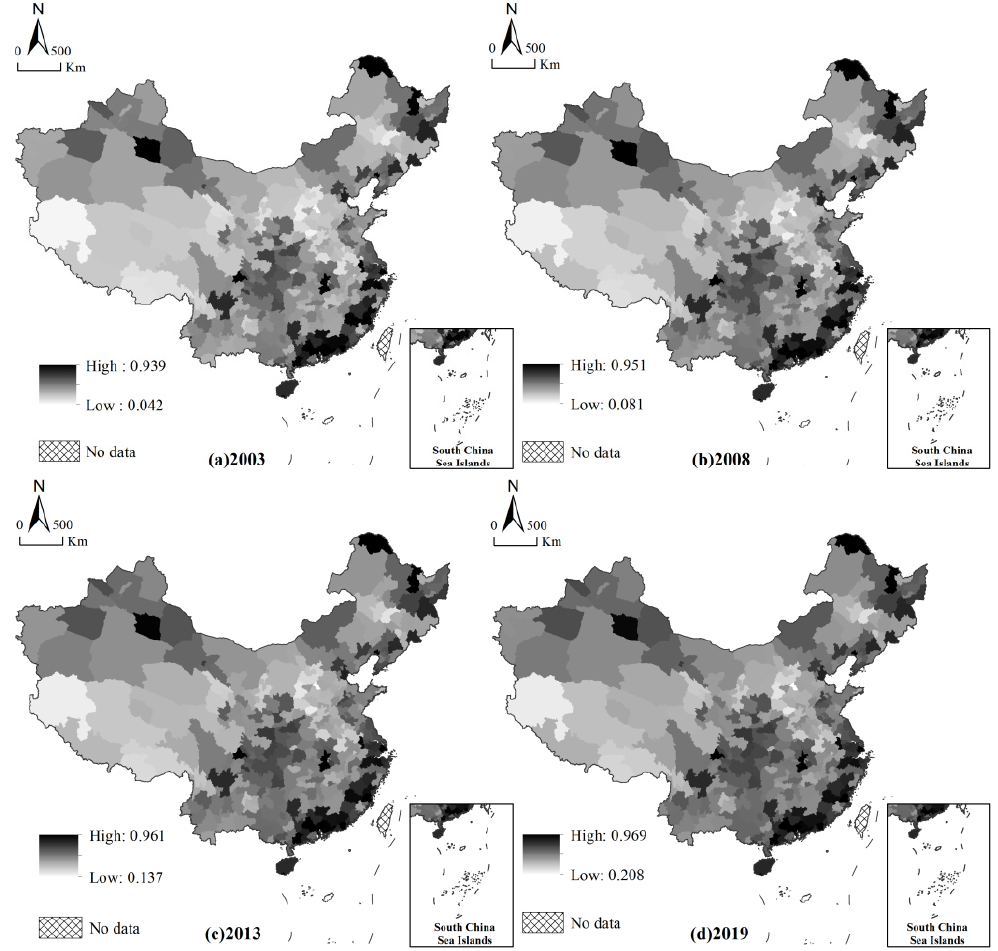
Figure 2. Results of cultivated land use efficiency from 2003 to 2019.